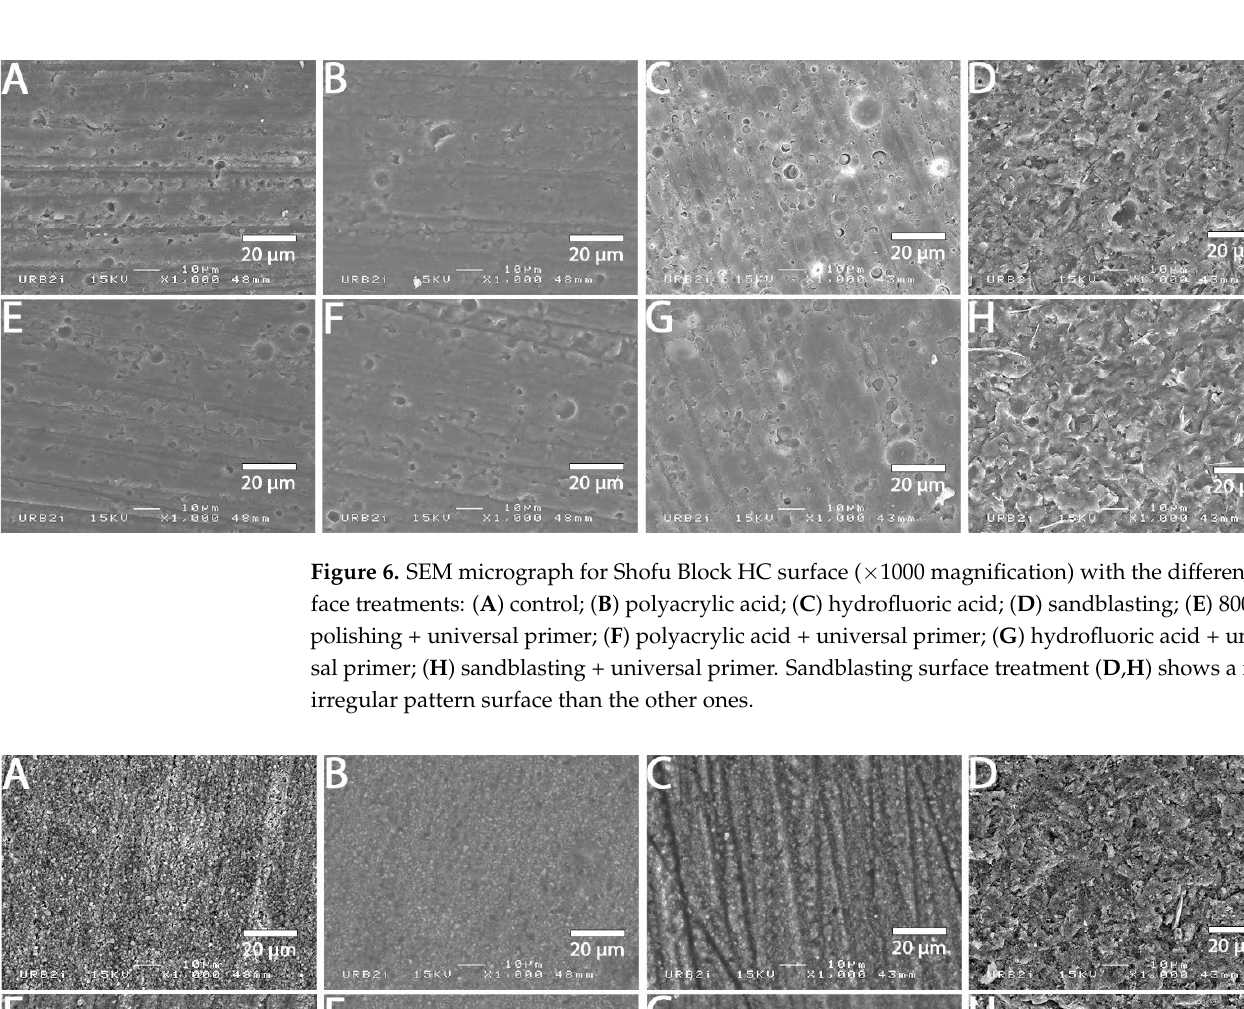
Figure 5. SEM micrograph for Lava Ultimate surface (×1000 magnification) with the different surface treatments: ( A ) control; ( B ) polyacrylic acid; ( C ) hydrofluoric acid; ( D ) sandblasting; ( E ) 800 grit polishing + universal primer; ( F ) polyacrylic acid + universal primer; ( G ) hydrofluoric acid + uni- versal primer; ( H ) sandblasting + universal primer. Sandblasting surface treatment ( D , H ) shows a more irregular pattern surface than the other ones.